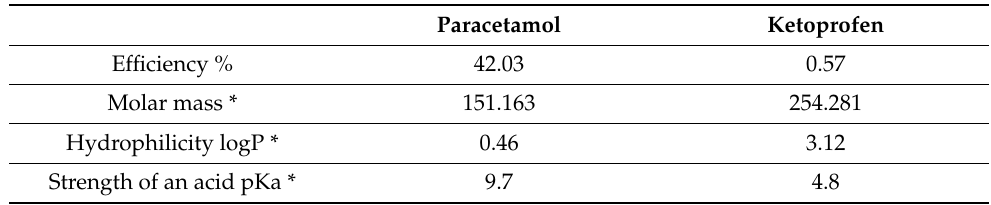
Table 5. Paracetamol and ketoprofen characteristics and annual average removal efficiency in the infiltration process during the research